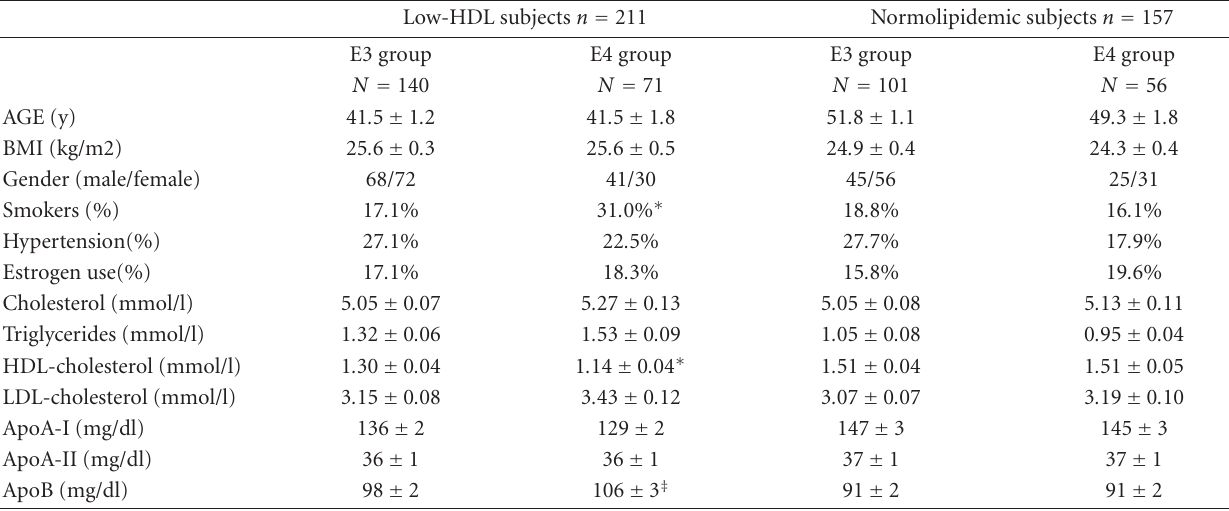
Table 1: The clinical characteristics and lipid values of the study subjects.